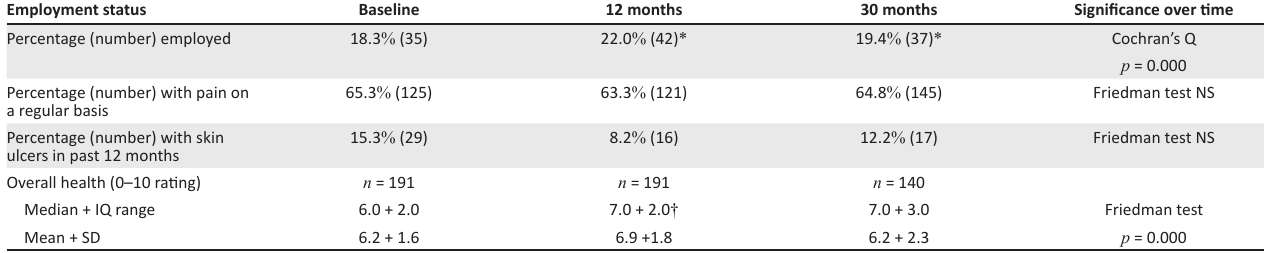
TABLE 4: Health and employment status over time. Employment status Baseline